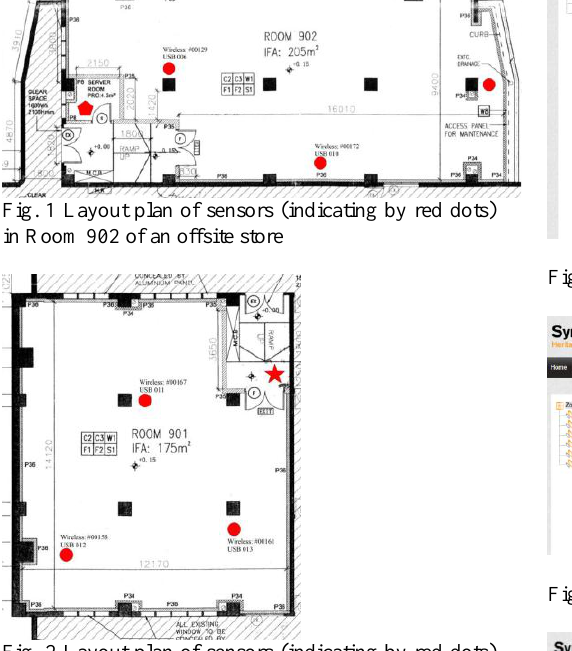
Fig. 2 Layout plan of sensors (indicating by red dots) in Room 901 of an offsite store